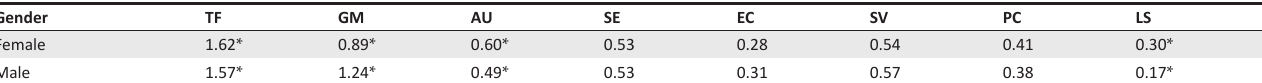
TABLE 6: Career anchors and gender in the short term (1 to 3 years). Gender TF GM AU